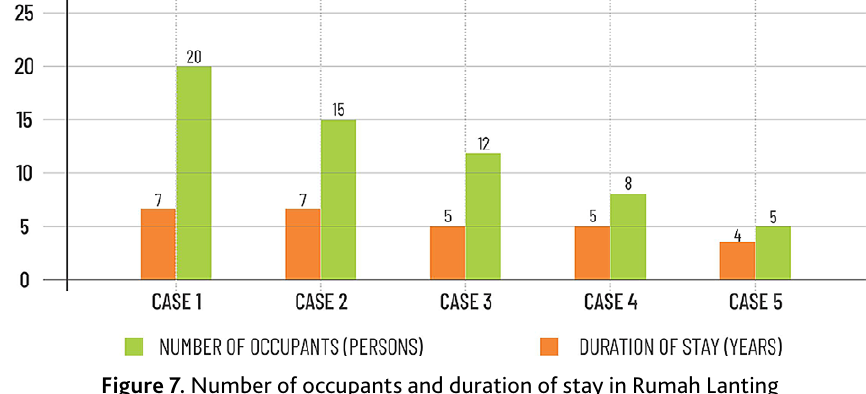
Figure 7. Number of occupants and duration of stay in Rumah Lanting